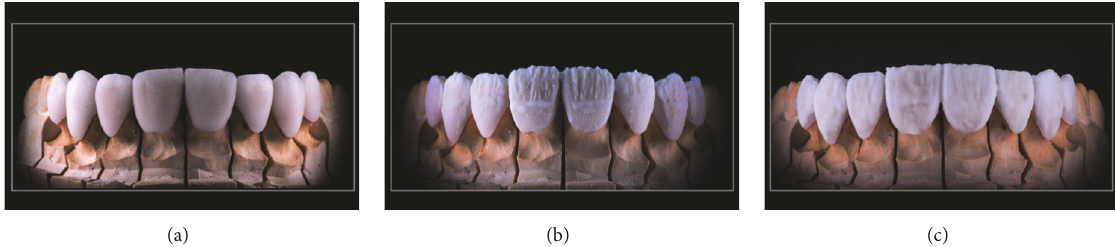
Figure 12: Ceramic layering technique. (a) The fitting of the veneers is being checked. (b) Power Dentin (IPS e.max Ceram) is being applied.